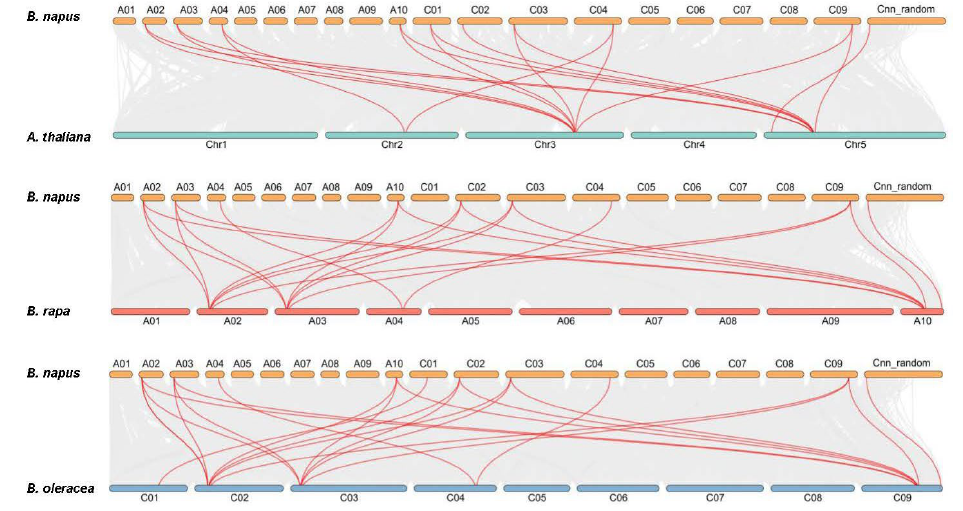
Figure 2. Syntenic relationship of HDAC genes in B. napus and three ancestral plant species. Grey lines in the background show the collinear blocks within rapeseed and other plant genomes, while the red lines highlight the syntenic HDAC gene pairs.